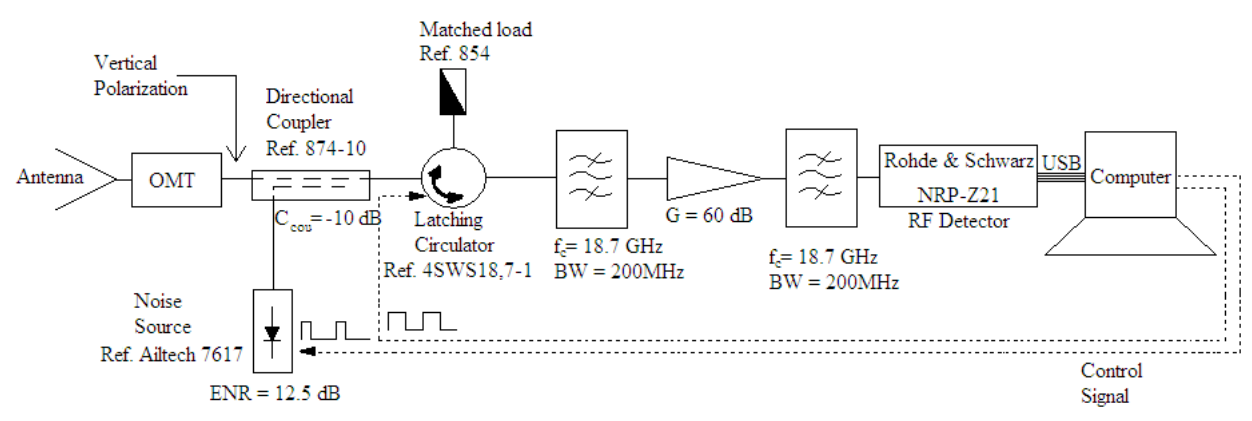
Figure 5. A block diagram of the K-band radiometer.